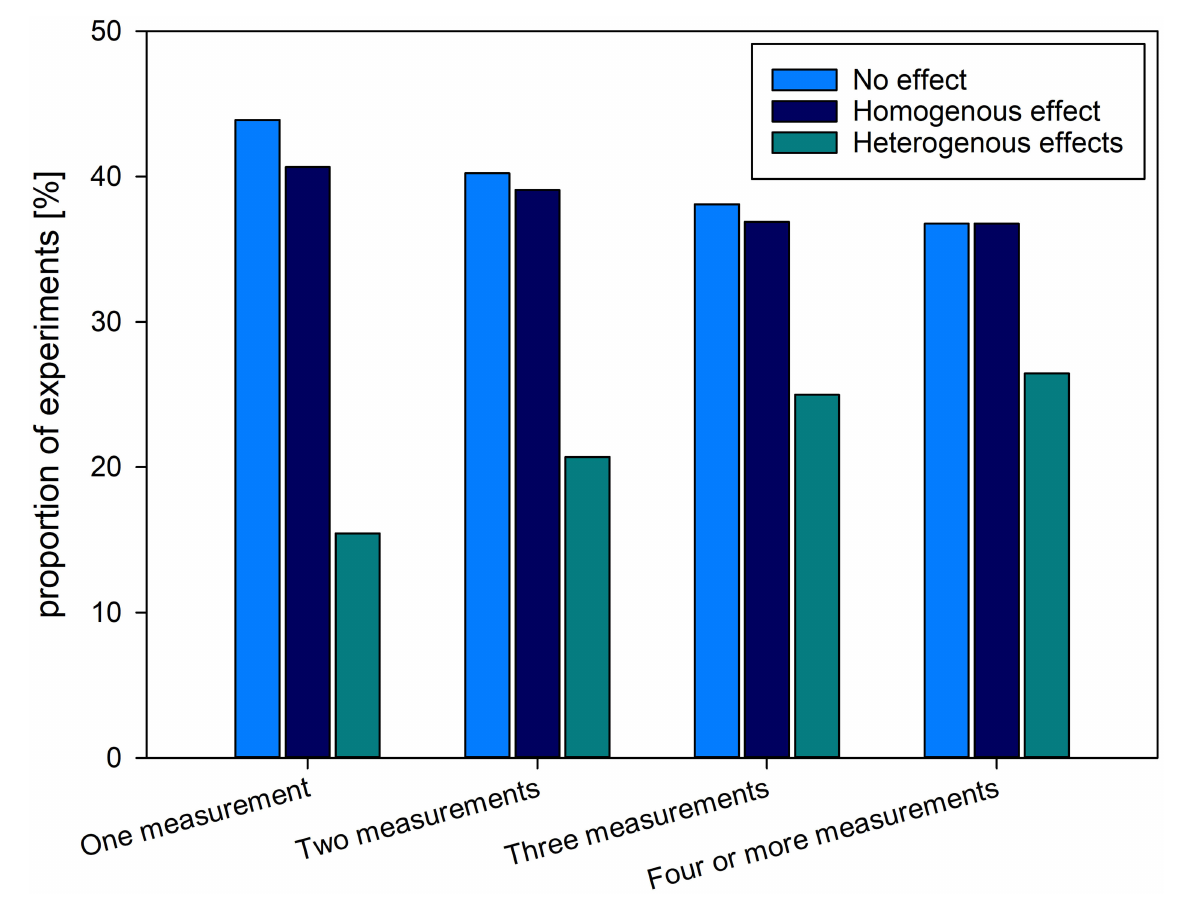
FIGURE3 Proportion and total numbers of experiments (517 experiments in 509 studies) finding a homogenous (consistent change in readout parameter compared to baseline/control), heterogenous (inconsistent change in readout parameter compared to baseline/control) or no effect of the intervention on GC levels among the different experimental designs with regard to the number of timepoints at which GC was measured during the experiment. Results are presented in proportions [(%), left vertical axis] and total number of experiments [(k), right vertical